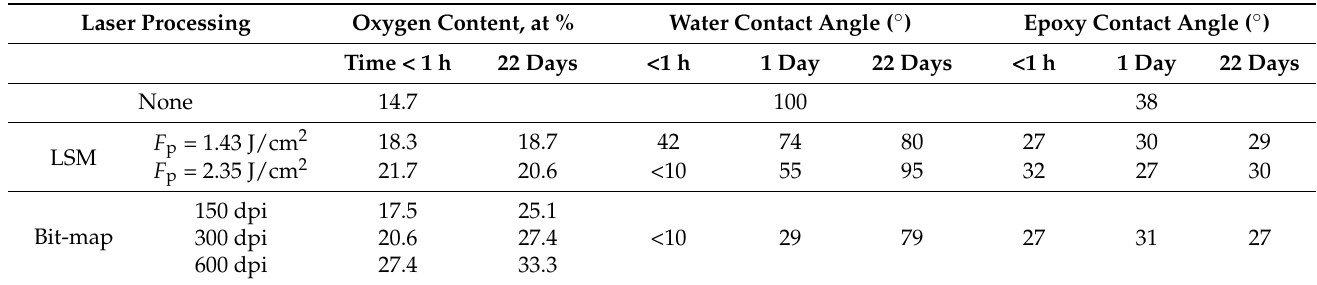
Table 1. Oxygen content and apparent contact angles (water and epoxy) of Cu surfaces at given times after laser processing. Laser Processing Oxygen Content, at % Water Contact Angle ( ◦